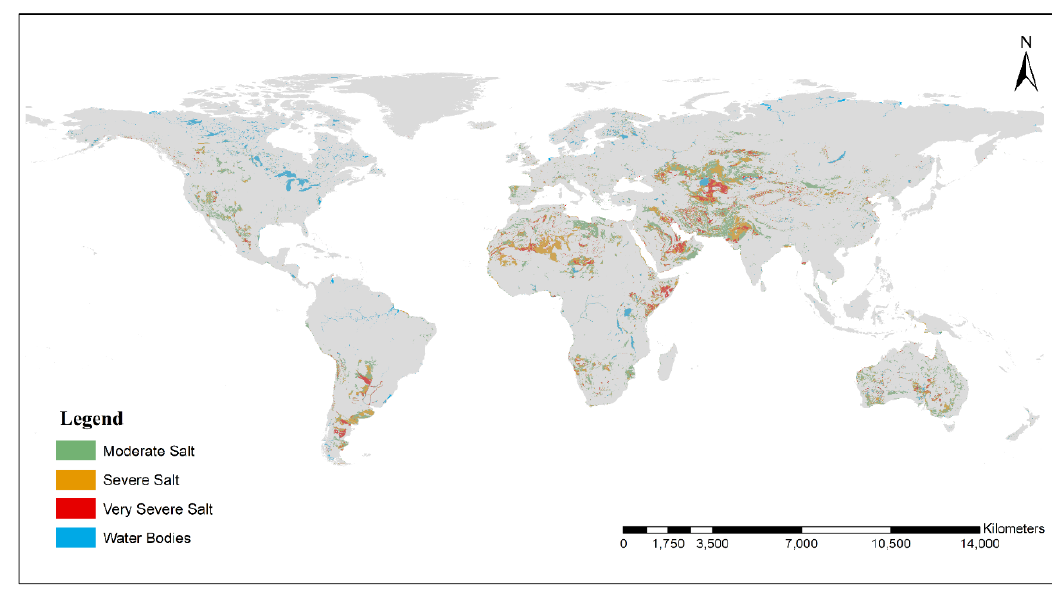
Figure 1. Global salt-affected regions and their severity levels (drawn based on Harmonized World Soil Database v. 1.2 [20]).